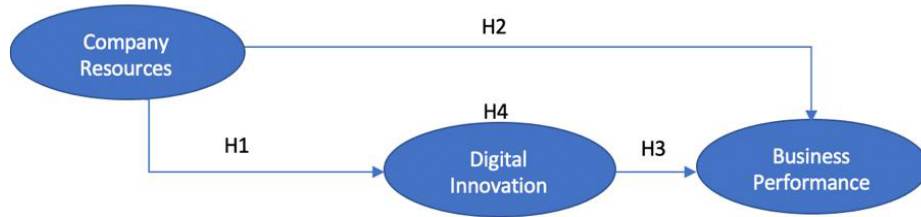
Figure 2. The Research Model Framework. Source: Researcher.